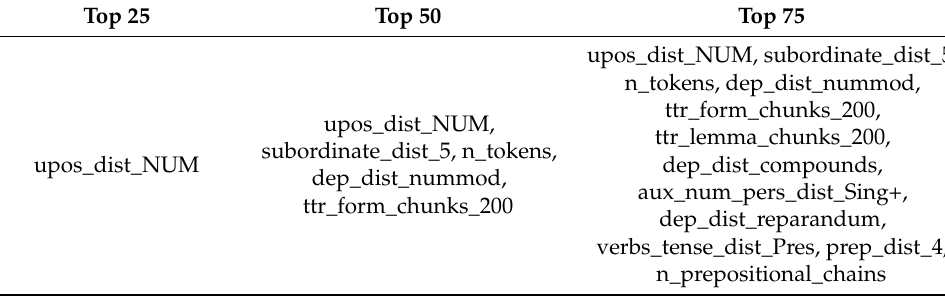
Table 8. Genre selection of top features.